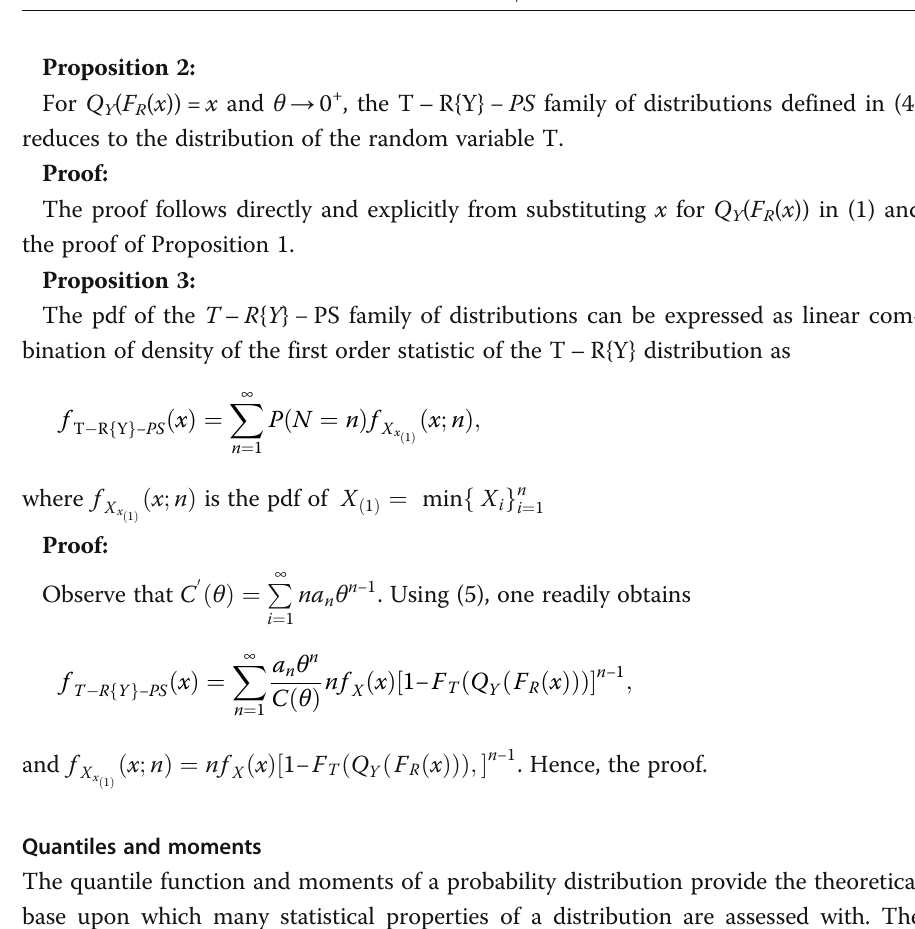
Table 3 Some distributions of Y with corresponding Q Y ( p ) and support of T Standardized distributions of the random variable Y The quantile function Q Y ( p ) Support of T Exponential − log(1 − p ) 0 < T < ∞ Logistic log( p /(1 − p )) − ∞ < T < ∞ Extreme value log( − log(1 − p )) − ∞ < T < ∞ log logistic p /(1 − p ) 0 < T < ∞ uniform p 0 < T < 1